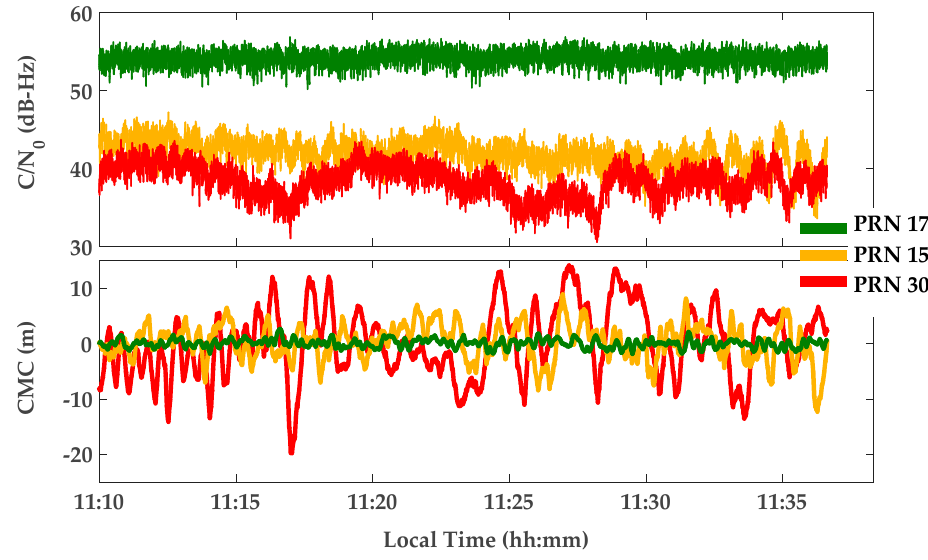
Figure 8. C/N 0 and CMC measurements for three types of PRNs: PRN 17 with low multipath (clean PRN), PRN 15 with medium multipath and PRN 30 with high multipath.